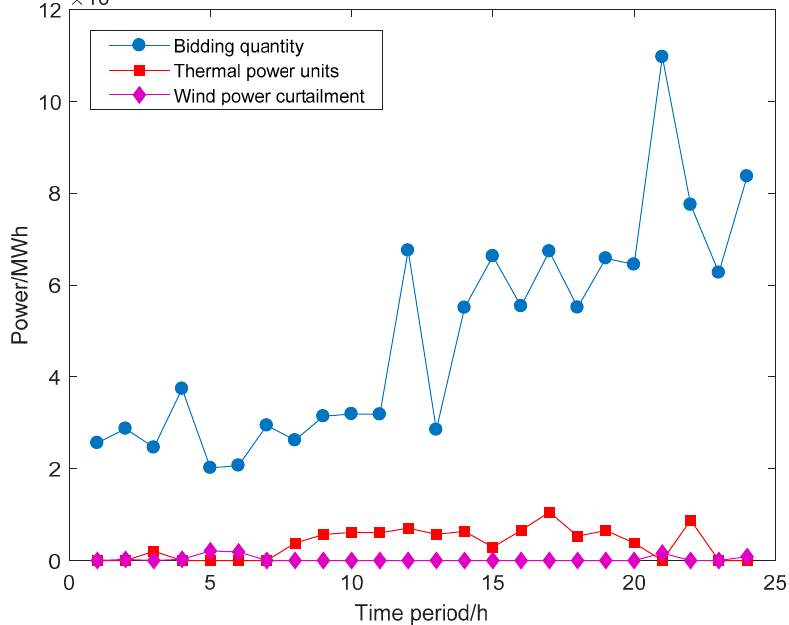
Figure 6. The optimal decision-making under the most optimistic scenario.